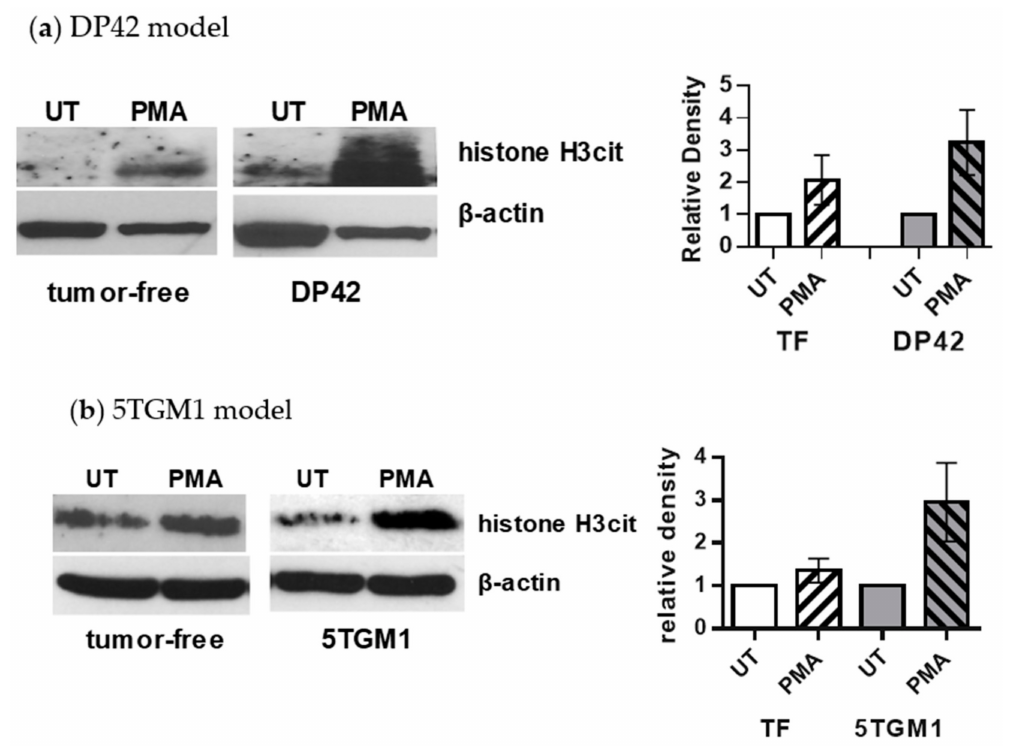
Figure 2. Level of citrullinated histone H3 in PMA-stimulated neutrophils from control and myeloma-bearing mice. Neutrophils were isolated from the BM of ( a ) DP42 myeloma-bearing or control tumor-free mice ( n = 5 and n = 4, respectively) or ( b ) 5TGM1-bearing or control tumor-free mice ( n = 3 for each group) and stimulated with 200 nM PMA for 4 h. Cells were then collected and subjected to Western blotting with antibodies against citrullinated histone H3. Equal loading was confirmed by re-probing membranes with antibodies against β -actin. Western blots are shown in Figure S1. Left, representative Western blots are shown. Right, densitometry results presented as mean ± SEM values are